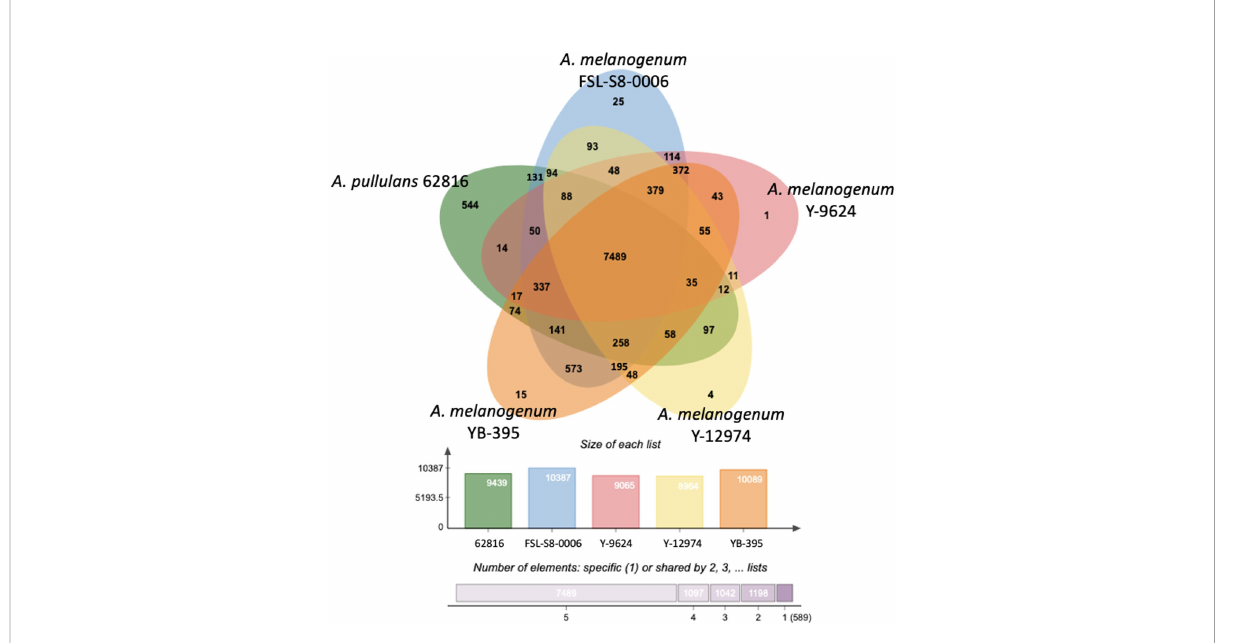
FIGURE 5 Distribution of unique protein coding genes or pseudogenes in Aureobasidium